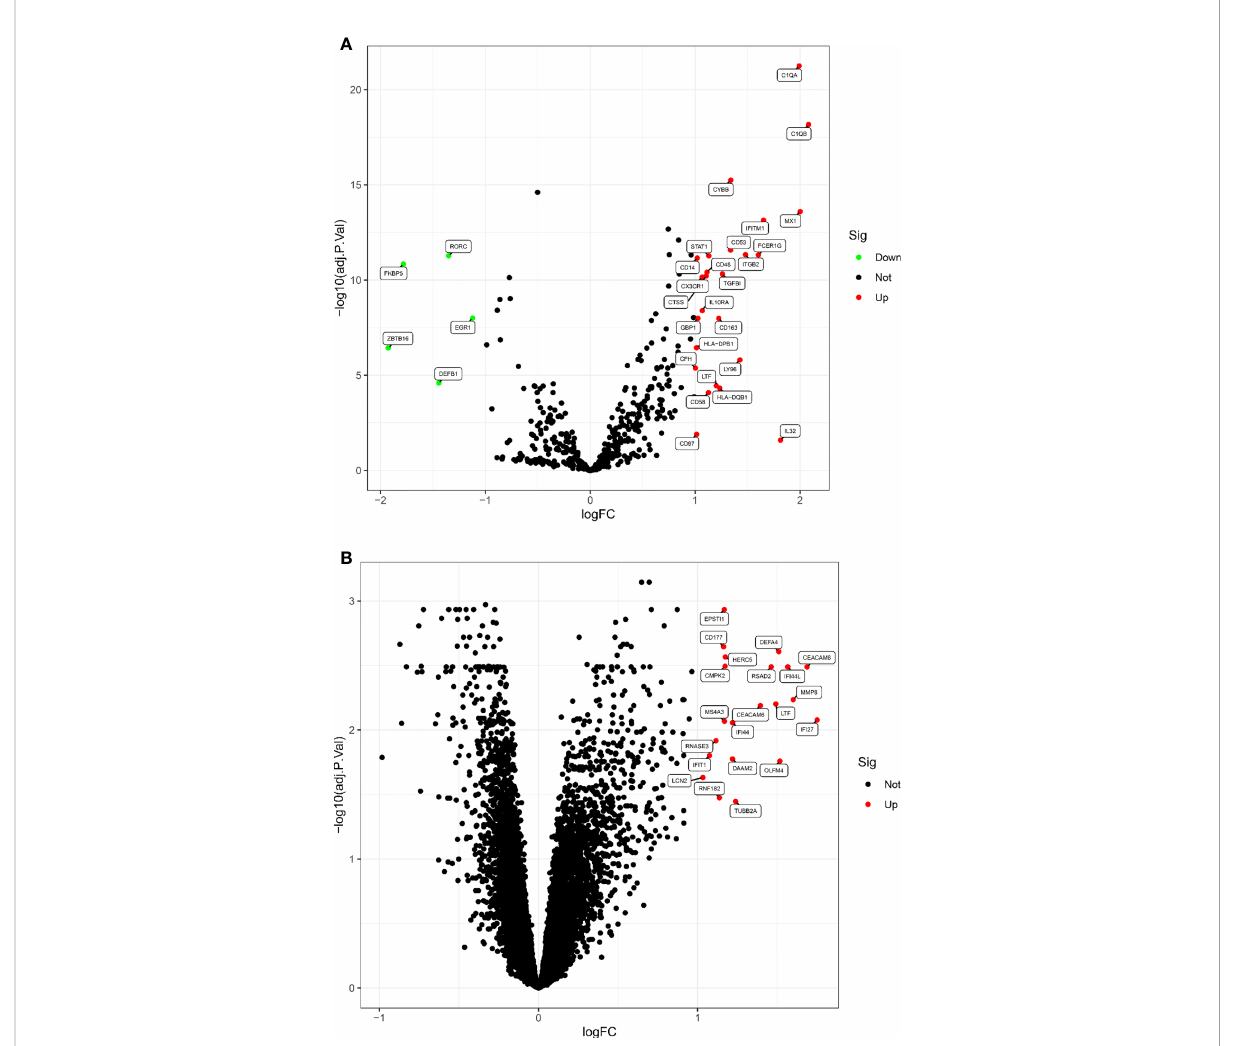
FIGURE 1 The volcano map of DEGs between LN and healthy samples. (A) Kidney tissue; (B) peripheral blood. Each dot represents a gene. Red dots indicate up-regulated gene expression; green dots indicate down-regulated gene expression; black dots indicate no signi fi cant difference between these genes in LN. The horizontal axis indicates the fold difference in gene expression in LN compared to healthy controls, and the vertical axis indicates the signi fi cance of the difference (adj. P.